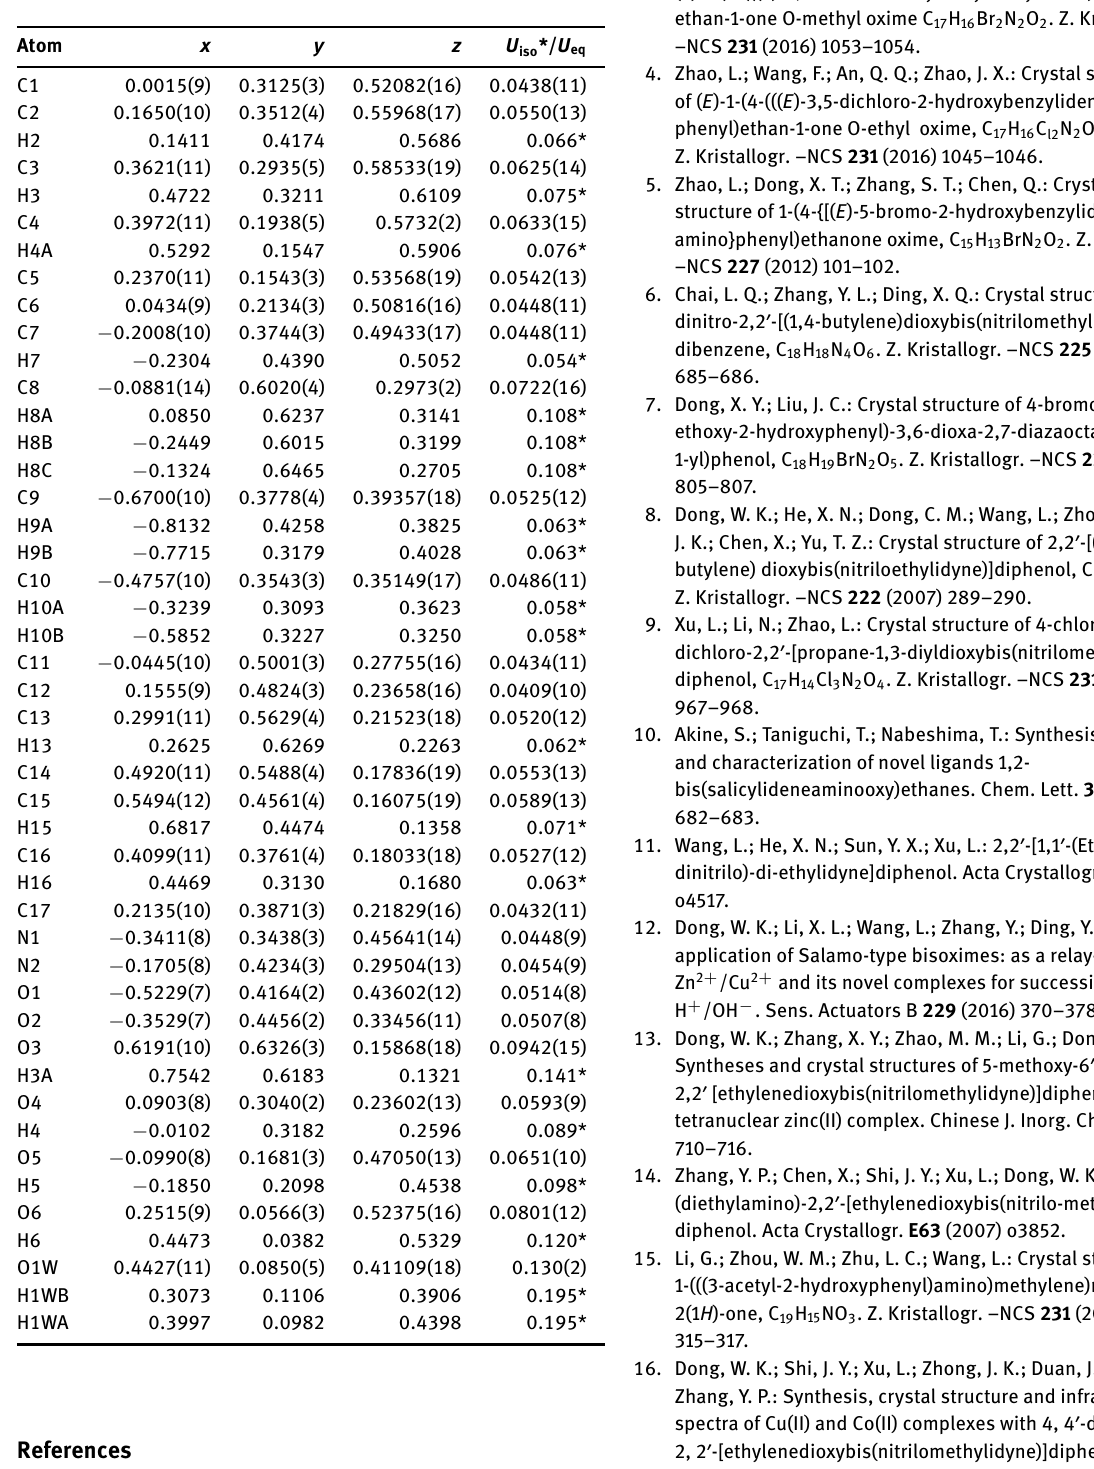
Table 2: Fractional atomic coordinates and isotropic or equivalent isotropic displacement parameters (Å 2